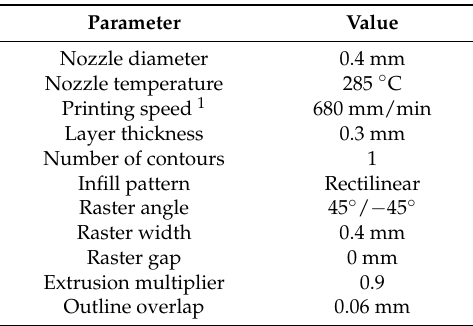
Figure 1. PPS 3D printing: ( a ) Schematic diagram of PPS 3D printing; ( b ) image of the extrusion head. Table 1. Printing parameters of 3D-printed PPS.